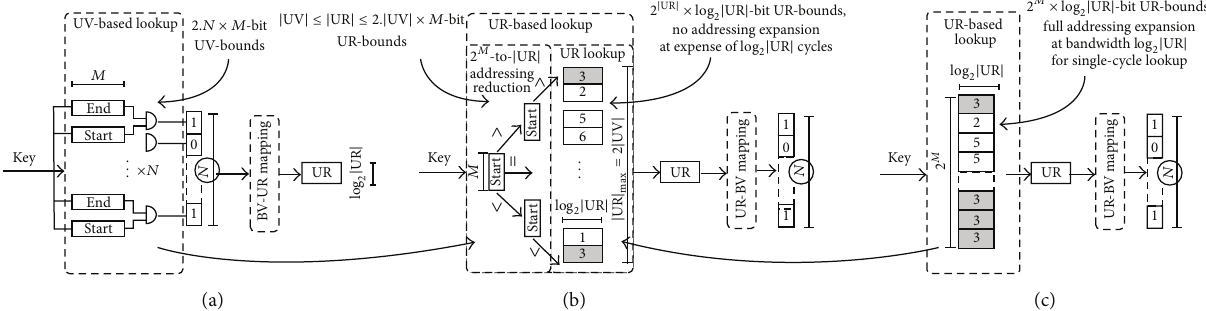
Figure 8: 𝑁 -rule lookup: (a) UV-based by concurrent matching of rule bounds, (b) UR-based by reducing memory expansion through a binary tree, and (c) UR-based by full memory